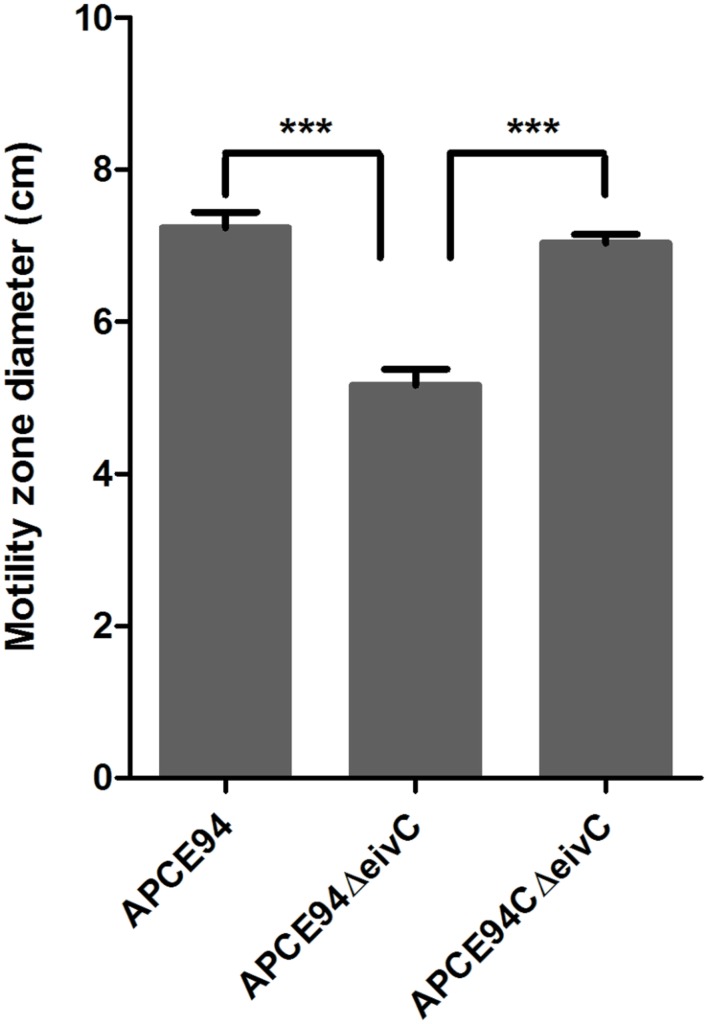
Effects of EivC on bacterial motility. Mutant strain APCE94ΔeivC exhibited a smaller motility diameter than the wild-type strain APCE94 and the complementation strain APCE94CΔeivC. Bars represent the average motility diameters of triplicate motility plates. Error bars represent the standard deviation. One-way ANOVA was used for the motility analysis (∗∗∗p < 0.001).